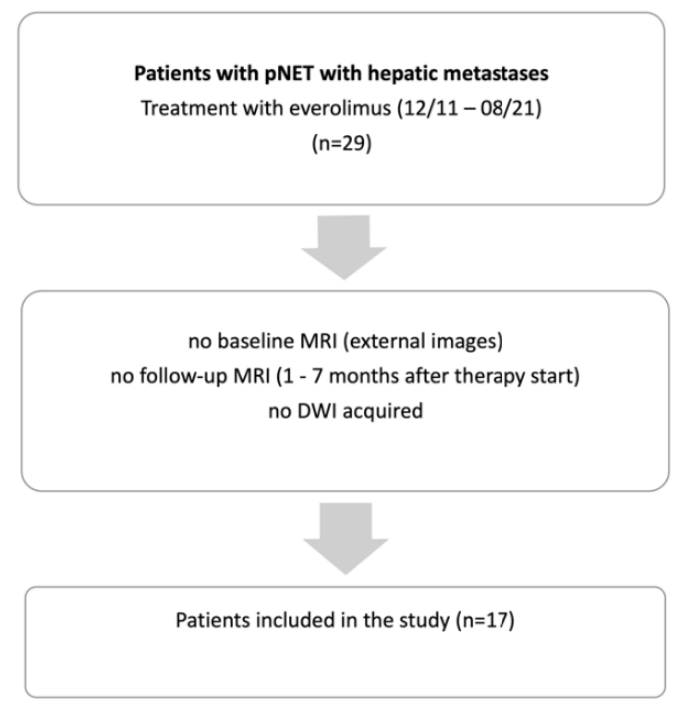
Figure 1. Flow-chart illustrating retrospective patient selection.